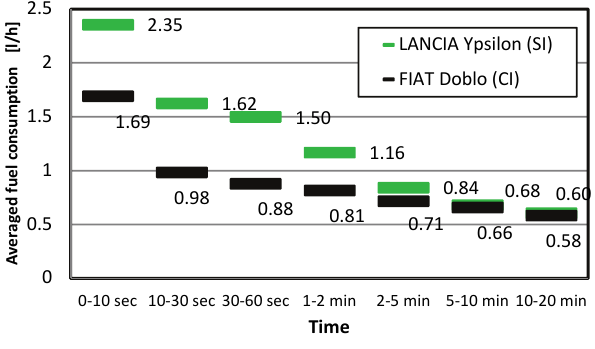
Fig. 8. Averaged fuel consumption at the temperature +25°C